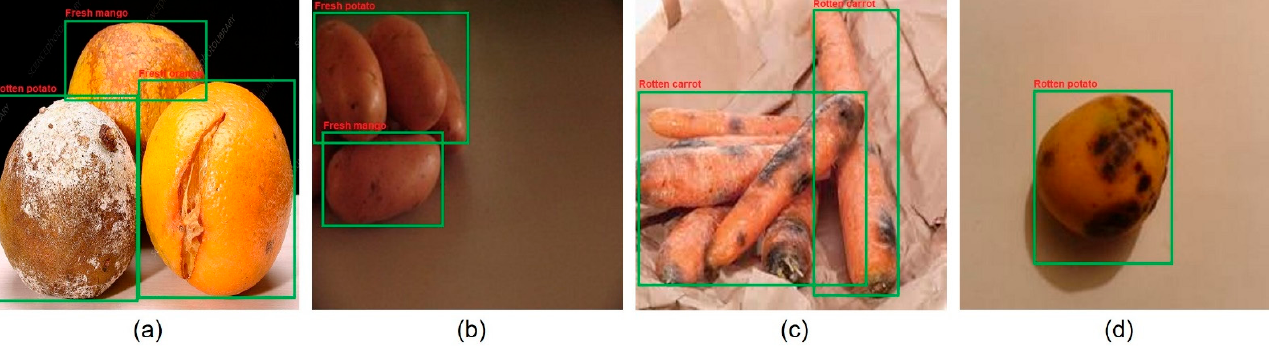
Table 8. Average frame processing time per sequence, measured in seconds. The average image input size is 640 by 640 pixels.